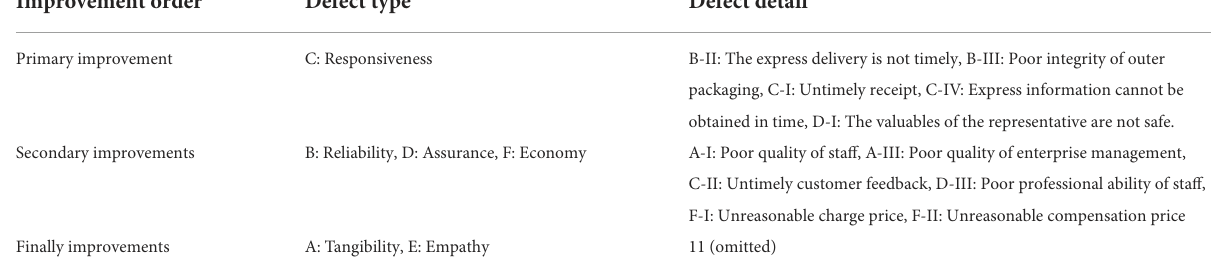
TABLE 6 Improvement order of defect dimension and defect